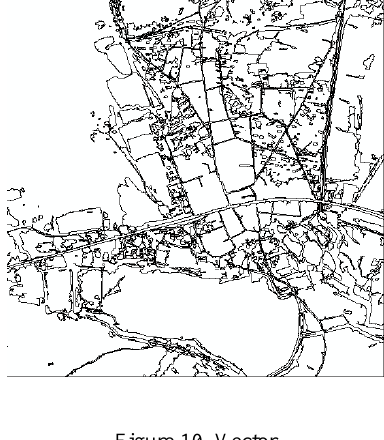
Figure 10. Vector